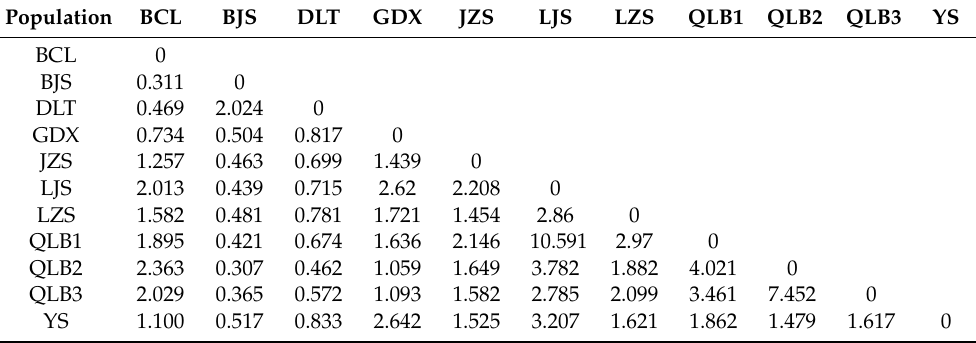
Table 4. Historical gene flows between 11 populations of R. rex subsp. rex.